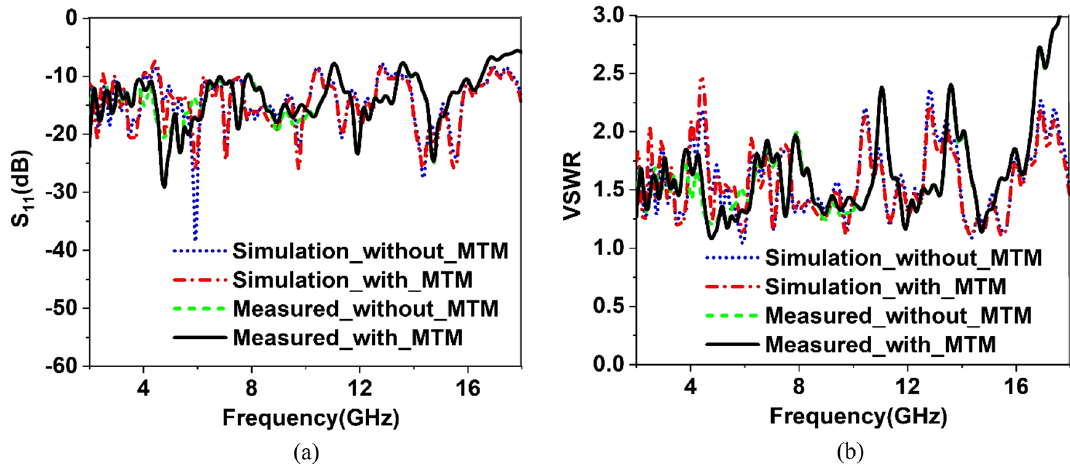
Figure 37. Comparison of simulated and measured results of the proposed antenna with and without metamaterial cover: ( a ) S 11 ( b ) VSWR.